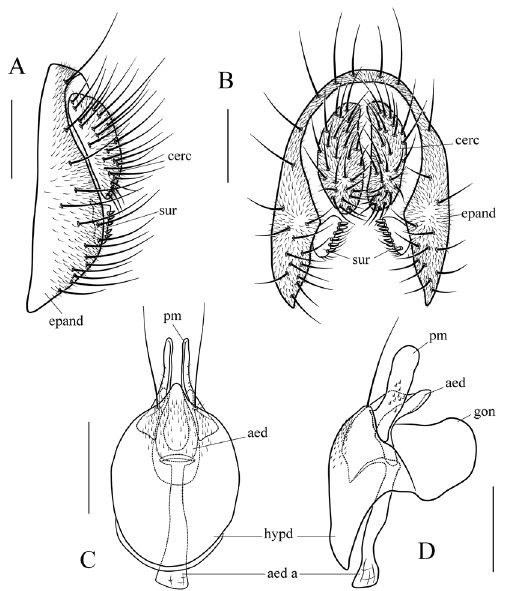
Figure 8. Scaptodrosophila parabrunnea (Tsacas & Chassagnard, 1976). A, B epandrium (epand), surstylus (sur) and cercus (cerc) (lateral and posterior views) C, D hypandrium (hypd), parameres (pm), gonopods (gon), aedeagus (aed) and aedeagal apodeme (aed a) (ventral and lateral views). Scale bars 0.1 mm.